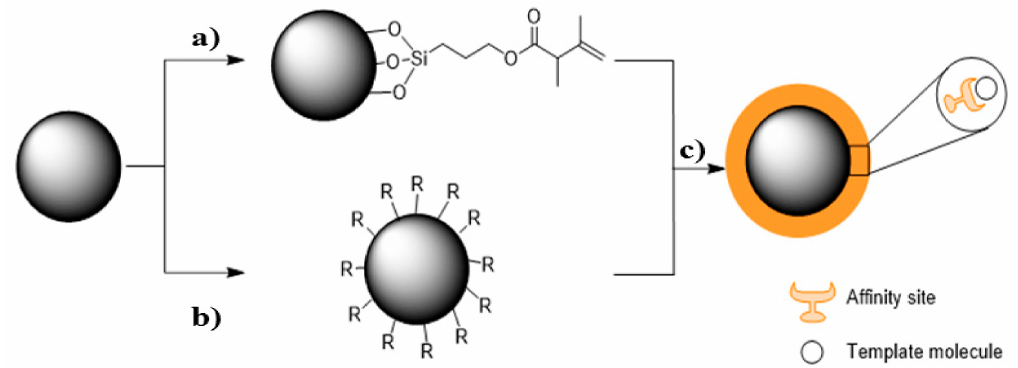
Figure 1. Scheme for the production of MIP-layered silica beads: ( a ) 3-(Trimethoxysilyl) propyl methacrylate (MPS)-functionalization in scCO 2 ; ( b ) plasma functionalization of silica beads, in which R are the radicals produced; ( c ) MIP-layered core-shell beads produced in scCO 2 . Reproduced from reference [52] with permission from